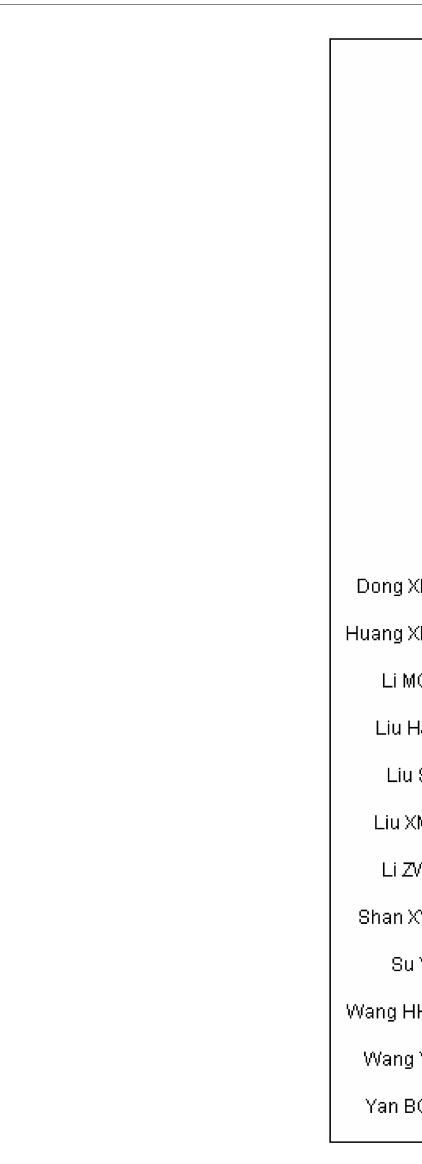
FIGURE 2 Assessment of risk of